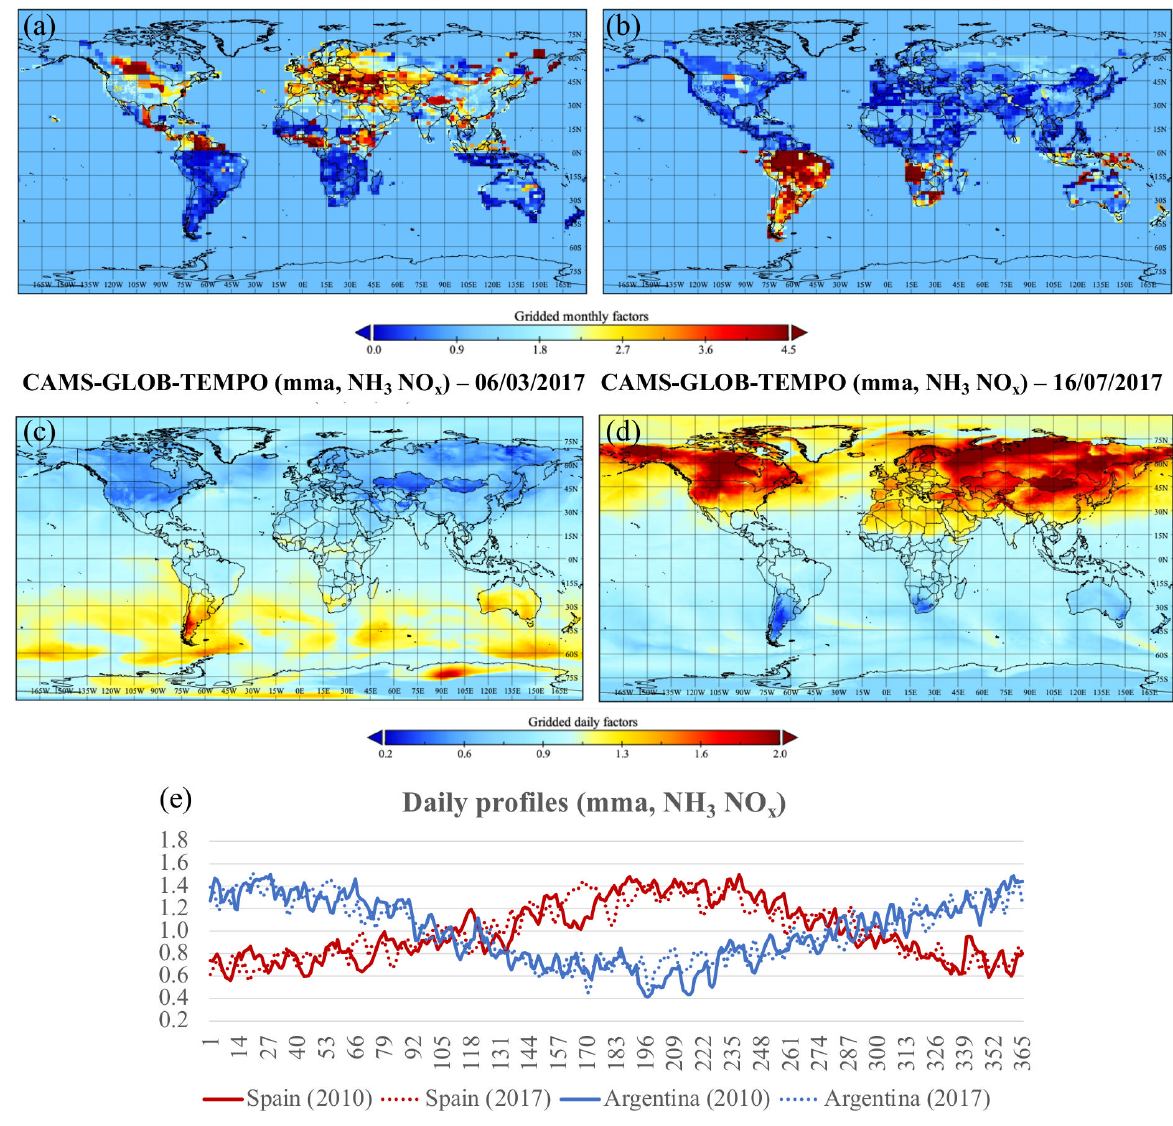
Figure 8. CAMS-GLOB-TEMPO (0.1 × 0.1 ◦ ) monthly- (a, b) and daily-scale (c, d) factor maps for agriculture (agr) NH 3 emissions and livestock (mma) NH 3 and NO x emissions for April and November and 6 March and 16 July 2017, respectively. Daily factors for livestock emissions (mma) obtained over Spain and Argentina for 2010 and 2017 (e) . Administrative boundaries are derived from the Micro World Data Bank (MWDB2,